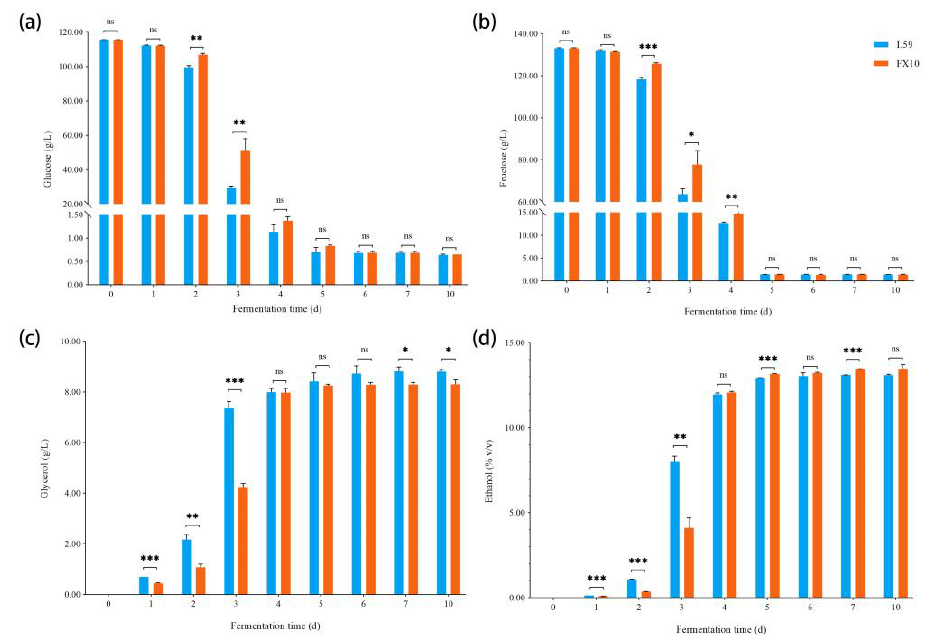
Figure 2. Changes of physicochemical indexes during the fermentation of the two groups. ( a ) Glucose; ( b ) Fructose; ( c ) Glycerol; ( d ) Ethanol. Note: p -values are indicated with asterisks (*). * 0.01 < p < 0.05, ** 0.001 ≤ p < 0.01, *** p < 0.001; ns indicates no significance. Table 1. The physicochemical indexes of Prince grape must and wine.